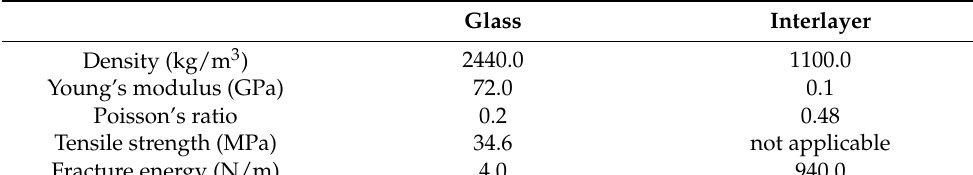
Figure 5. The impact of the laminated glass (Reprinted from Ref. [43]): ( a ) The dimension; ( b ) Figure 6. Mesh configuration for the FDEM analysis. Loading condition. Table 2. Material properties used in the laminated glass analysis.